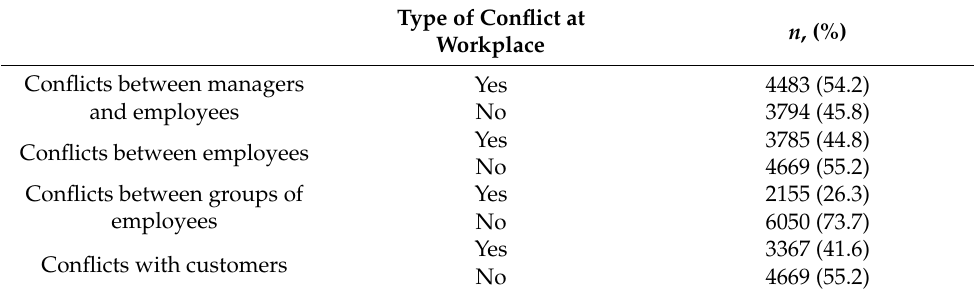
Table A3. The distribution of the studied types of conflict at the workplace in the sample, n